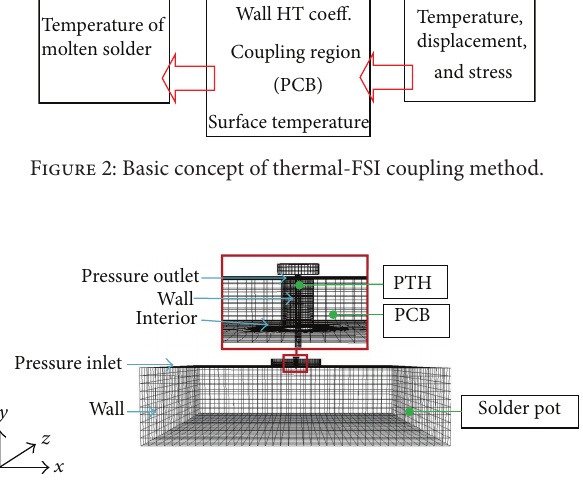
Figure 3: FLUENT meshed model and boundary conditions.